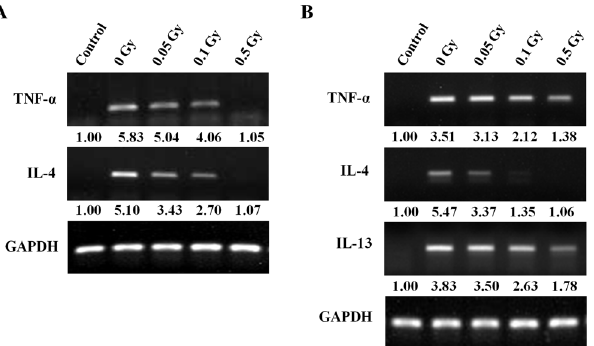
Fig 7. The changes in cytokine mRNA in the ear tissues. TNF- α , IL-4, IL-13 mRNA was determined by RT-PCR in ear tissue of passive cutaneous anaphylaxis (A) and late-phase cutaneous mouse model (B). Semi-quantitative data was indicated as the fold. Each number represents the mean of three experiments.